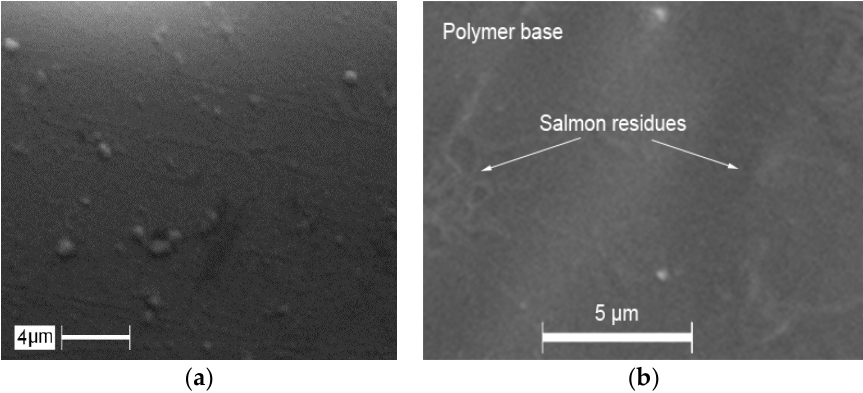
Figure 3. ( a ) The PET surface is homogeneous and free from defects, showing no adhesion of salmon muscle; ( b ) PET surface showing remnants of salmon muscle and displaying a heterogeneous morphology.